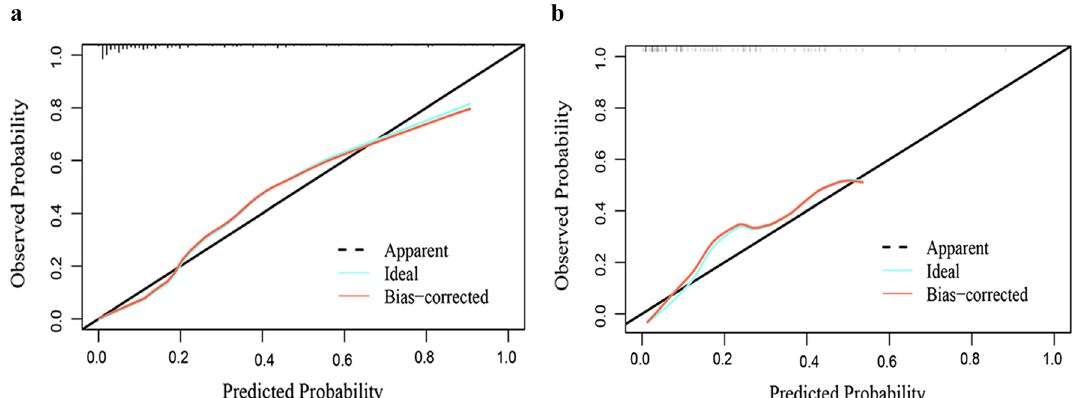
Fig. 5 The calibration curve for predicting the occurrence of ACLF within 90 days. The calibration curves of the model in the training group ( a ) and validation group ( b ) showed a good consistency. ACLF, acute-on-chronic liver